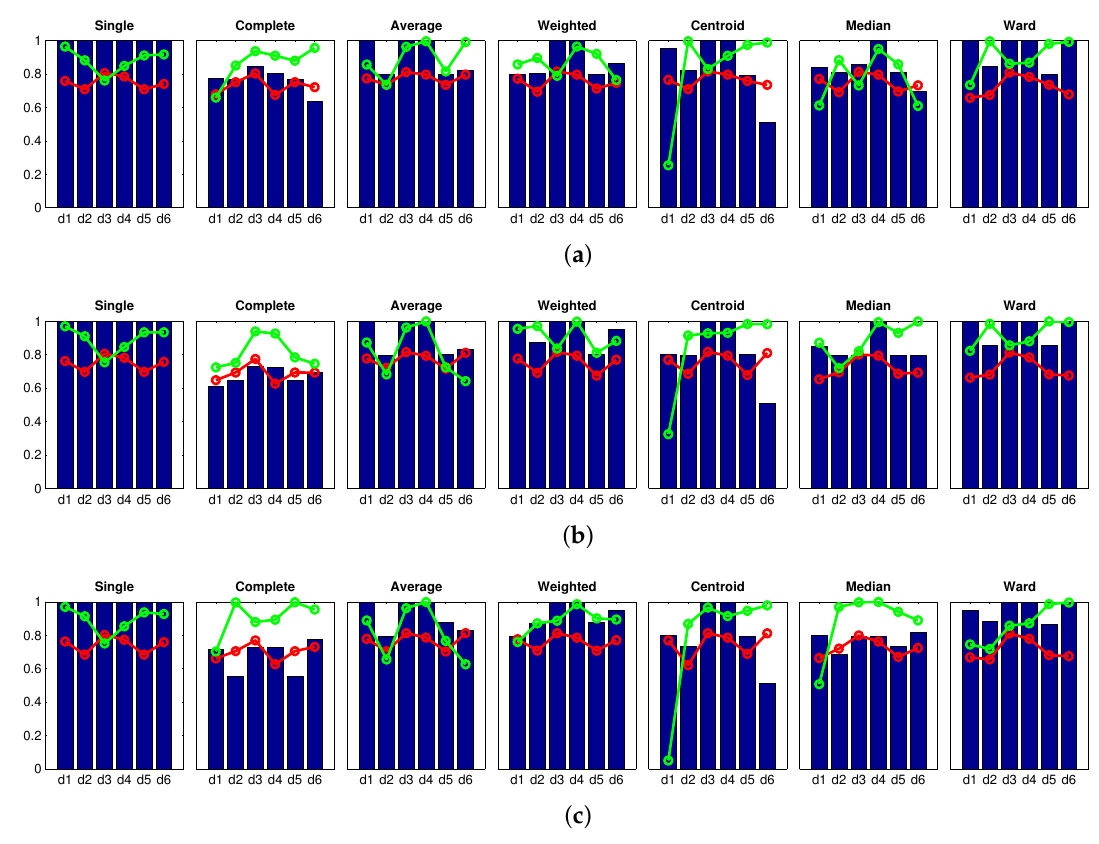
Figure 10. Legend: (cid:4) Accuracy c ; −◦− Correlation γ coph ; −◦− Inconsistency δ inconsist . Results of the high-level clustering using gist as global-appearance descriptor and ( a ) m = 16, k 6 = 8; ( b ) m = 16, k 6 = 16; ( c ) m = 32, k 6 = 32.